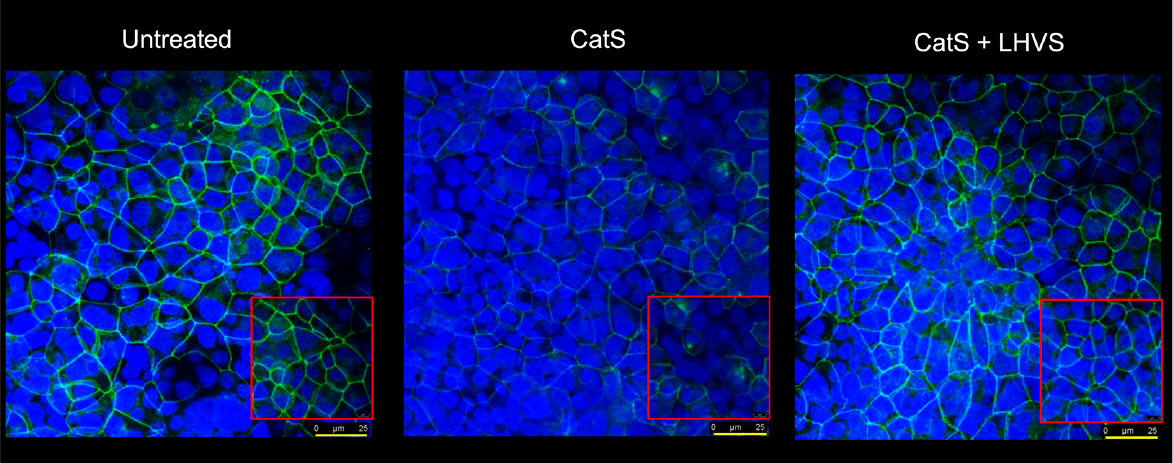
Figure 6. Immunofluorescence analysis. Epithelial 16HBE cells were seeded on Transwell inserts (submerged culture) and treated with CatS as described above for FITC-dextran assays. LHVS (1 µM) was used as control. Cells were exposed to an anti-occludin primary antibody and then incubated with a fluorescein-labeled anti-mouse IgG1 antibody. A representative immunofluorescence image from z-stacks overlaid with Hoechst 33342 nuclear stain of three independent experiments is shown. Scale bar: 25 µm (in yellow). The inserted area (framed: red color) corresponds to an original acquisition zoom (scale bar: 8 µm).